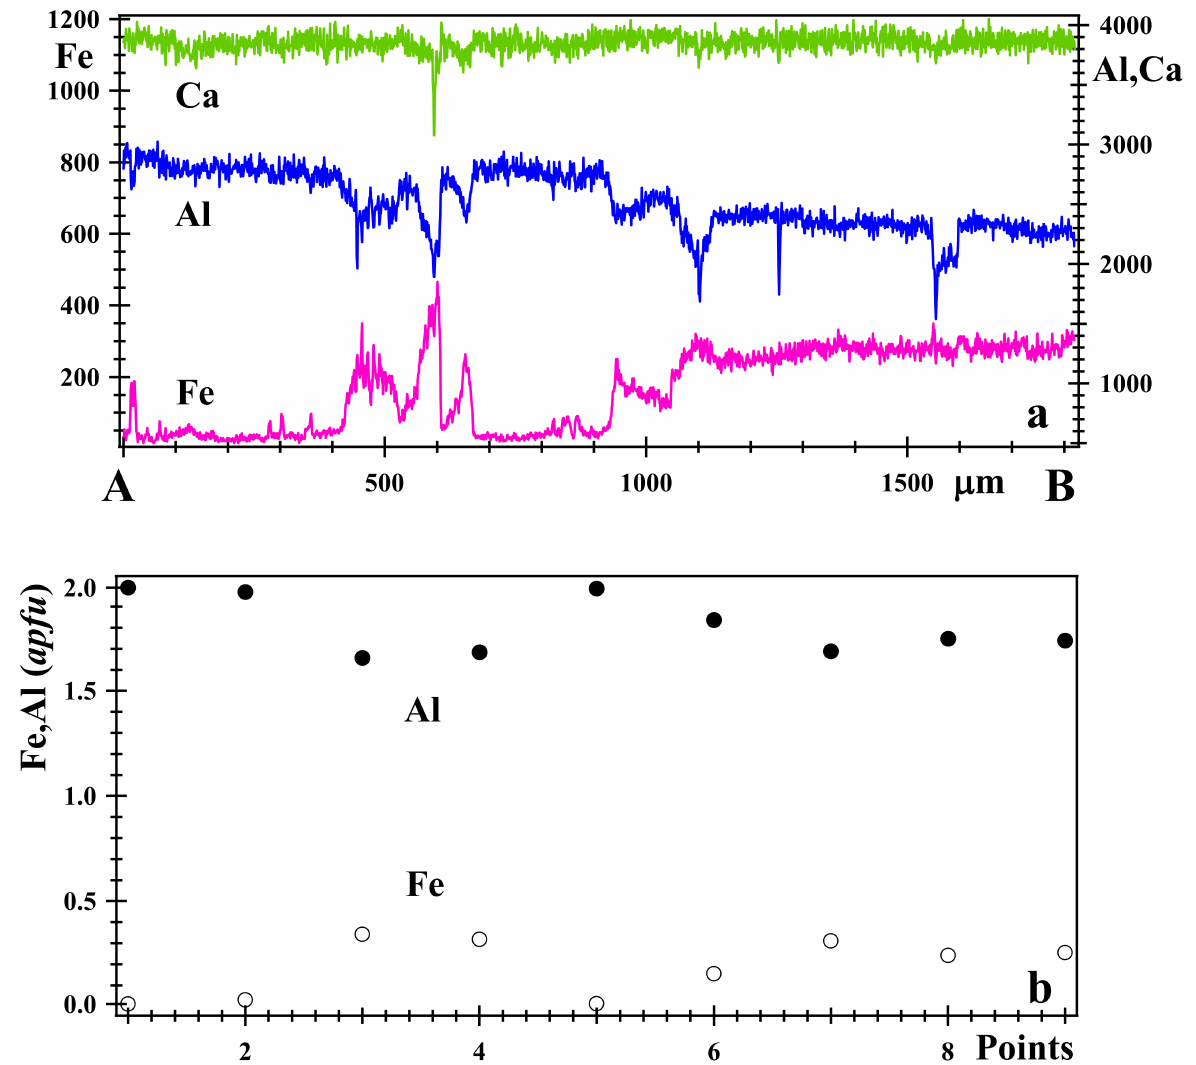
Figure 7. ( a ) Line scans along the line A to B in (Figure 6a) showing the inverse relation between Fe 3+ and Al 3+ cation content and nearly homogeneous Ca content for sample-4 from Chihuahua-p, Mexico. Two separate phases may be deduced from the line scans and the elemental maps in Figure 6, but such phases are most easily detected by HRPXRD (Figure 11). ( b ) Quantitative chemical analyses from points 1 to 9 showing the inverse relation between Al and Fe atoms in the Y site (Figure 6a). Note that Fe + Al = 2 apfu . The line scan units are